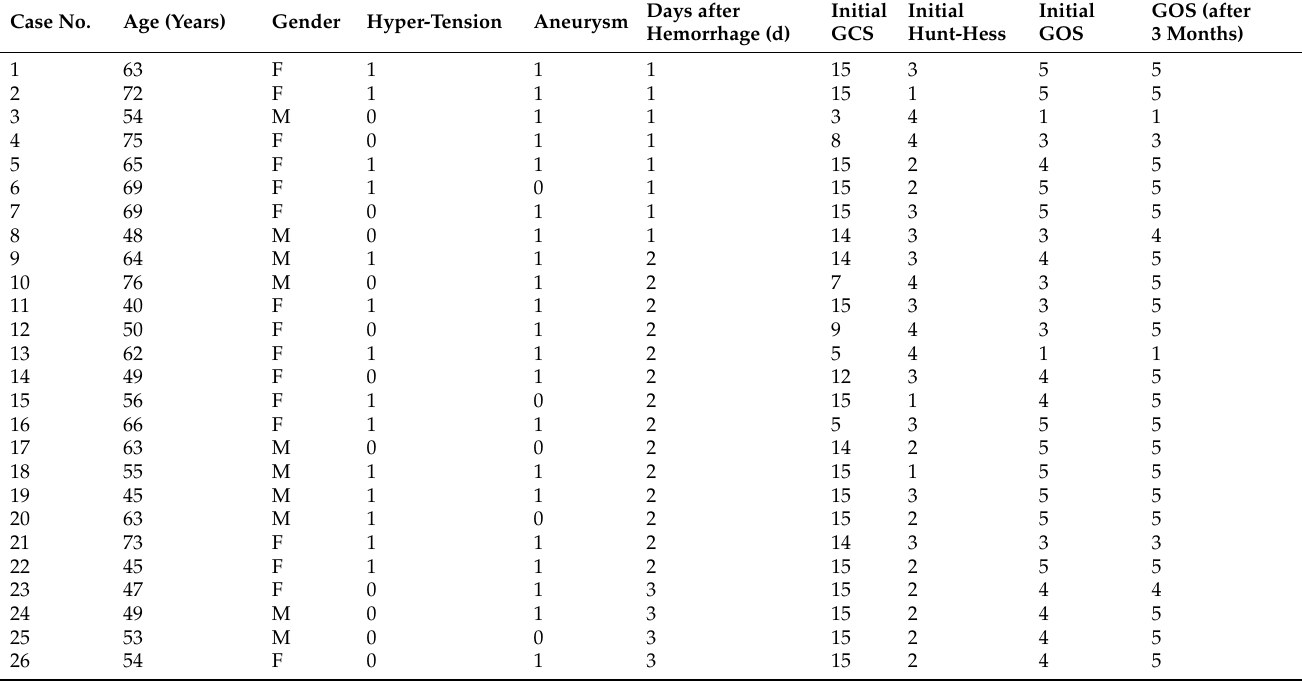
Table 1. Summary of demographic data in patients with